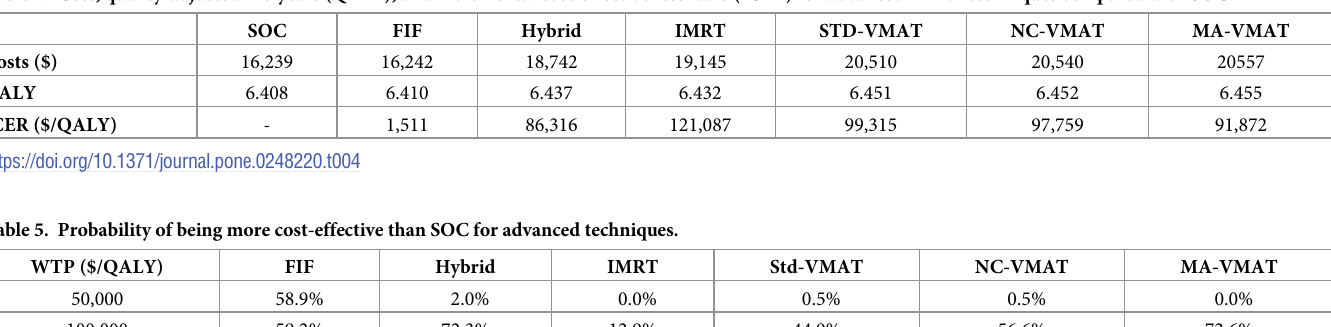
Table 4. Cost, quality-adjusted life-years (QALY), and incremental cost-effectiveness ratio (ICER) for advanced PMRT techniques compared with SOC.